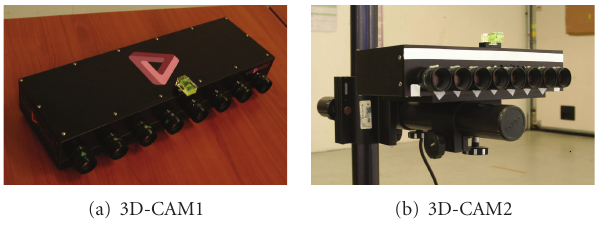
Figure 8: Camera box